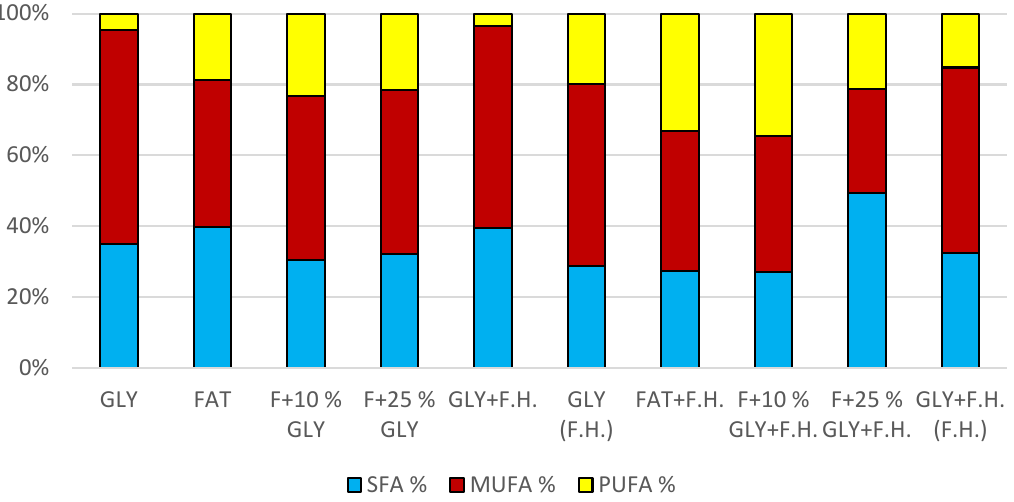
Figure 12. Fatty acid distribution in lipids of yeast strain Rhodotorula mucilaginosa in conditions of C/N ratio 25.